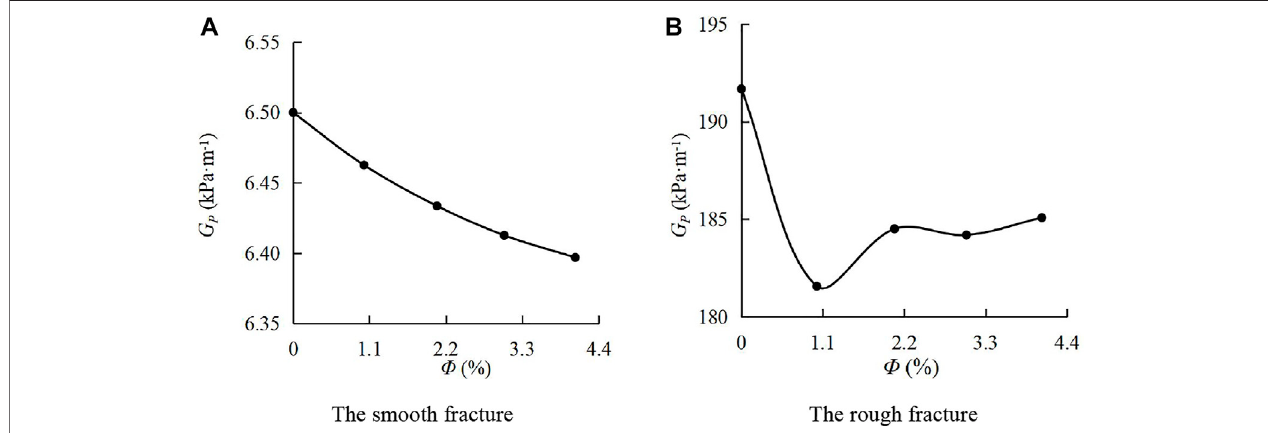
FIGURE 4 | Absolute value of the pressure gradient – volume concentration of sediment particle curves. (A) Smooth fracture; (B) rough fracture.